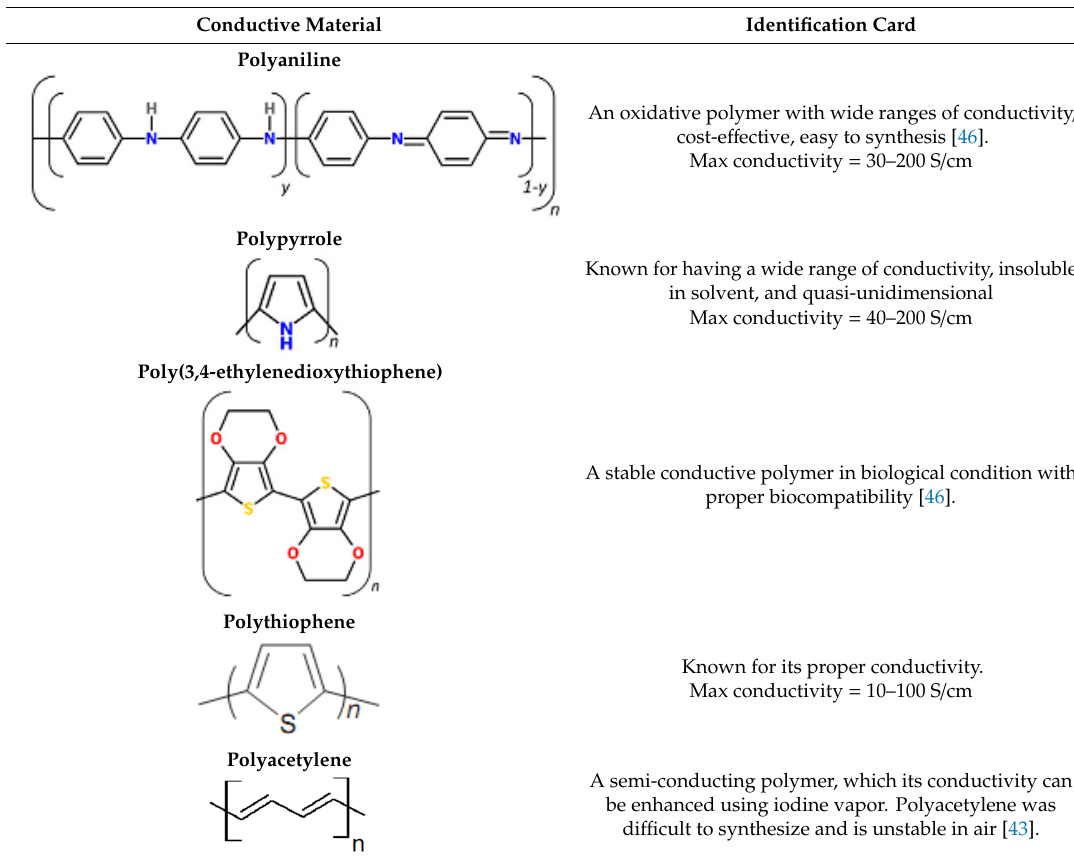
Figure 2. Effect of the electrical stimulation on the cell morphology and proliferation. Fluorescence microscopy of PC12 cells without stimulation, with constant 10 µA of stimulation and 10 µA, 20 Hz of stimulation. Electrical stimulation enhances cell proliferation. Amplitude stimulation a ff ects the cell morphology [45], copyright Elsevier, 2011. Table 1. Conductive materials used in tissue engineering.